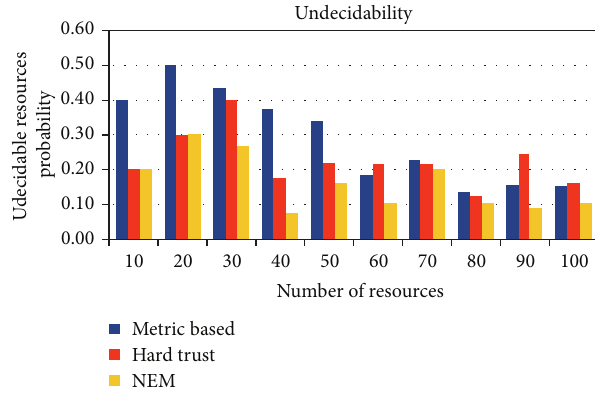
Figure 6: Unevaluated resources.